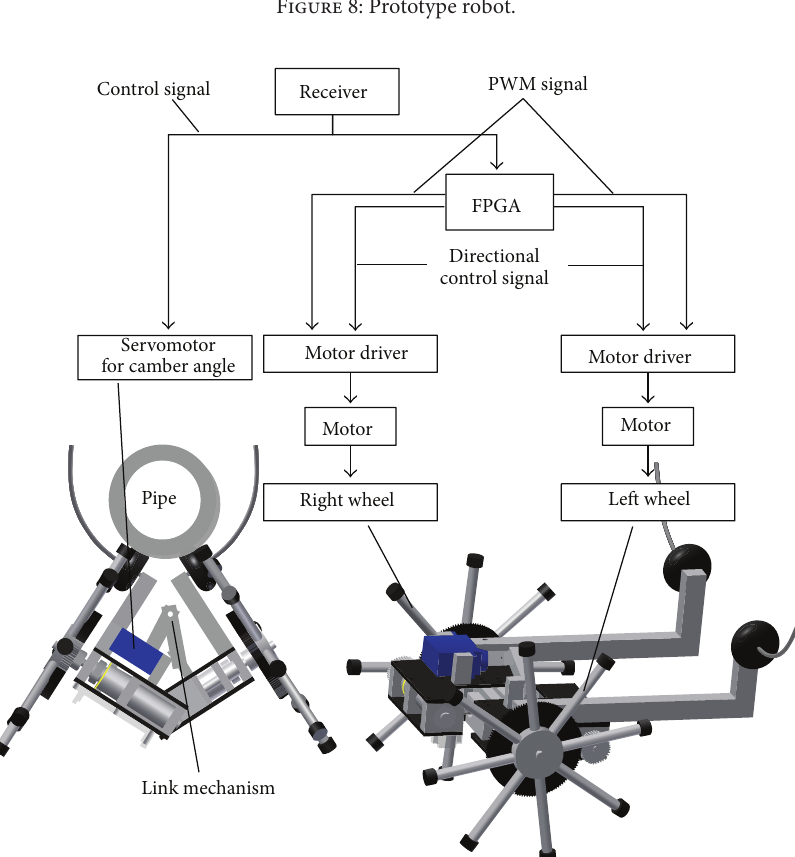
Figure 9: Signal flow for robot